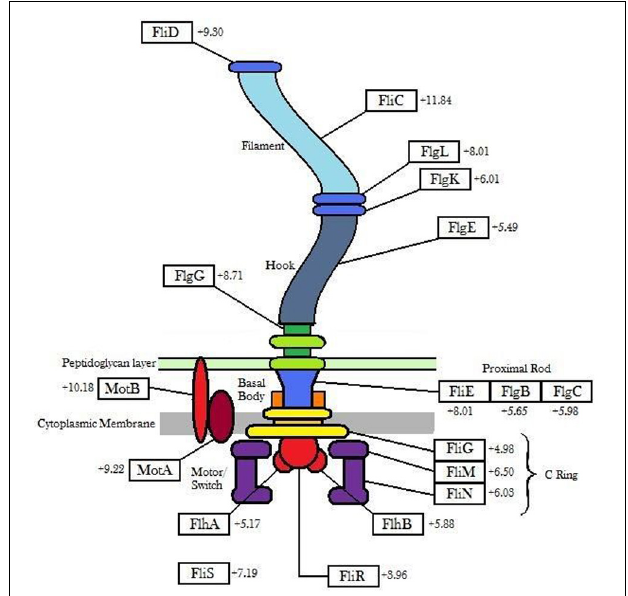
FIGURE 1 | Outline of flagellar genes (showing the degree of up-regulation) up-regulated in Listeria monocytogenes strain 6179 in the presence of